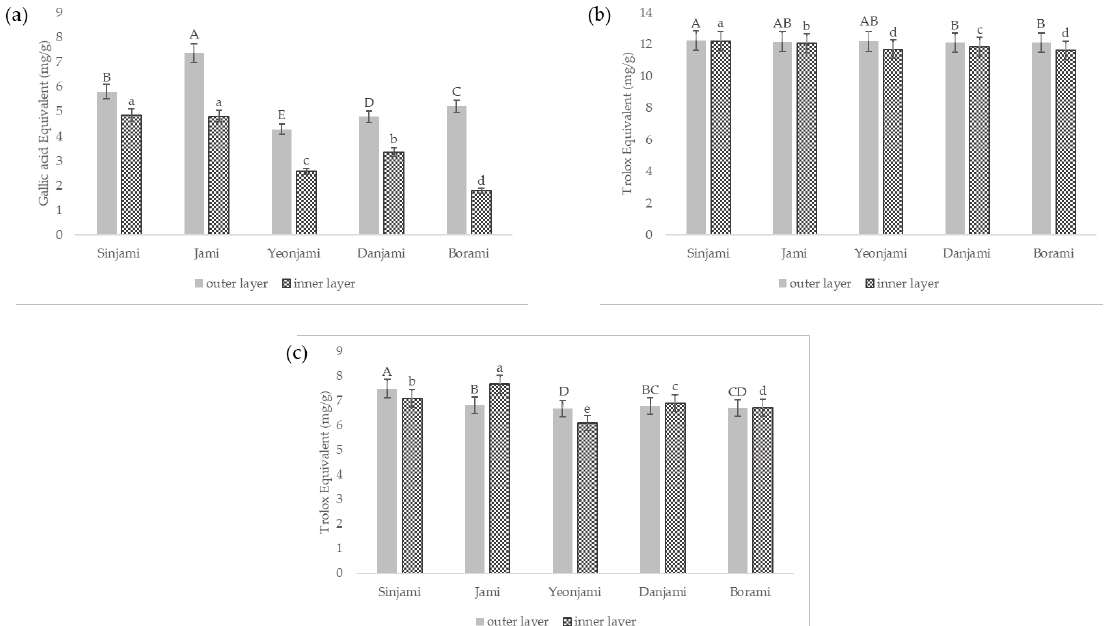
Figure 2. ( a ) Total phenolic content, ( b ) antioxidant activity measured by 2,2-diphenyl-1-picrylhydrazyl (DPPH) assay, and ( c ) antioxidant activity measured by performing 2,2′-azino-bis (3-ethylbenzothiazoline 6-sulphonic acid) (ABTS) assay of outer and inner layers of five purple sweet potato cultivars. Values designated with different uppercase and lowercase letters (A–D, a–d) differed significantly for the outer and inner layers, respectively ( p < 0.05).